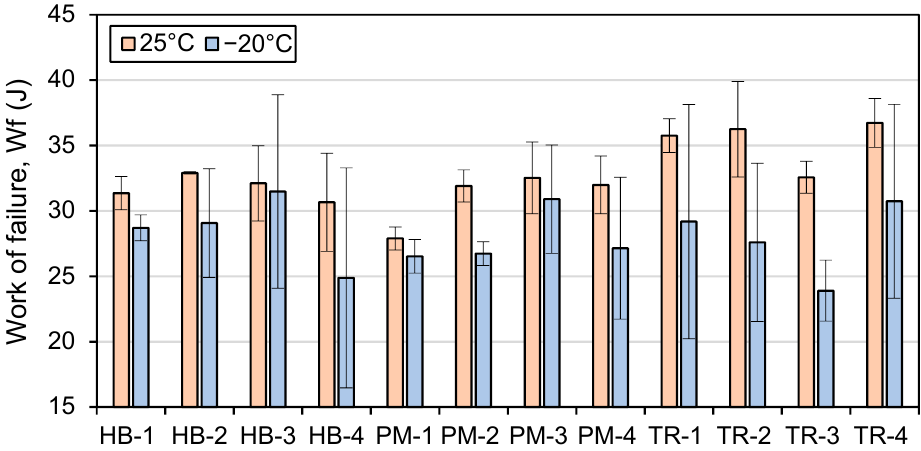
Figure 15. IDT results example: force recorded as a function of displacement for HB-1 specimens at 25 °C and − 20 °C. 25 °C and − 20 °C.